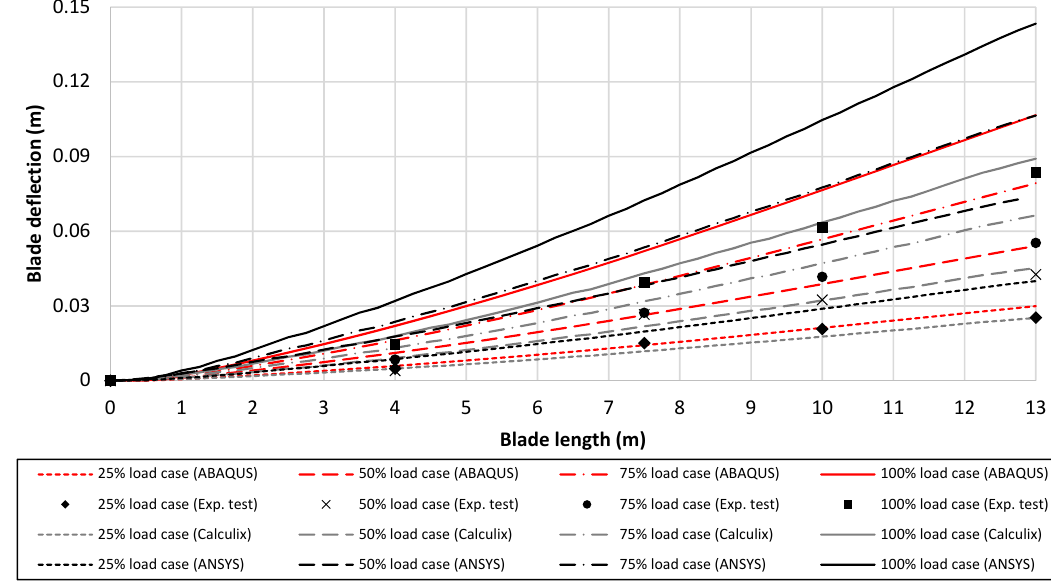
Figure 12. Comparison between the results from the 3 numerical models (ABAQUS, ANSYS, and CalculiX) and the results from the experimental static test showing the deflection along the blade (in m) for each of the load cases in the edgewise direction.